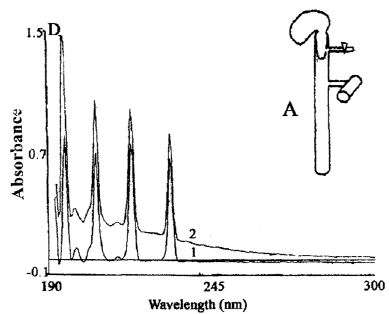
Figure 13. Right panel: The Thunberg apparatus (A) with a welded cylindrical cuvette with quartz sides. Left panel: Curve 1—the optical absorption of gaseous NO (four narrow equidistant bands), Curve 2—the sum of optical absorptions of gaseous NO and NO 2 (the structureless spectrum) [87] (With permission).